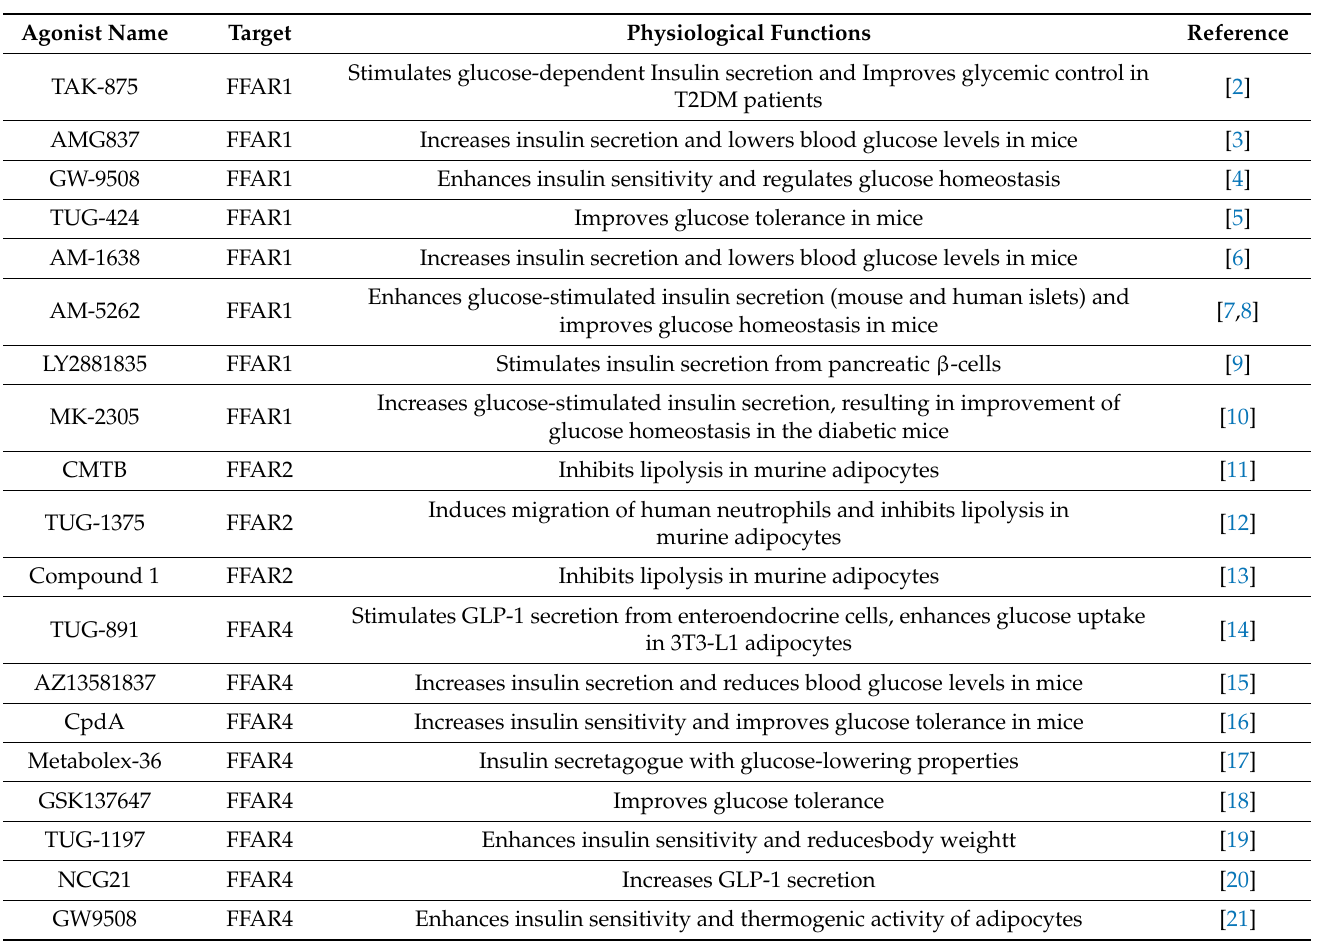
Table 2. List of synthetic agonists of FFAR isoforms and their physiological